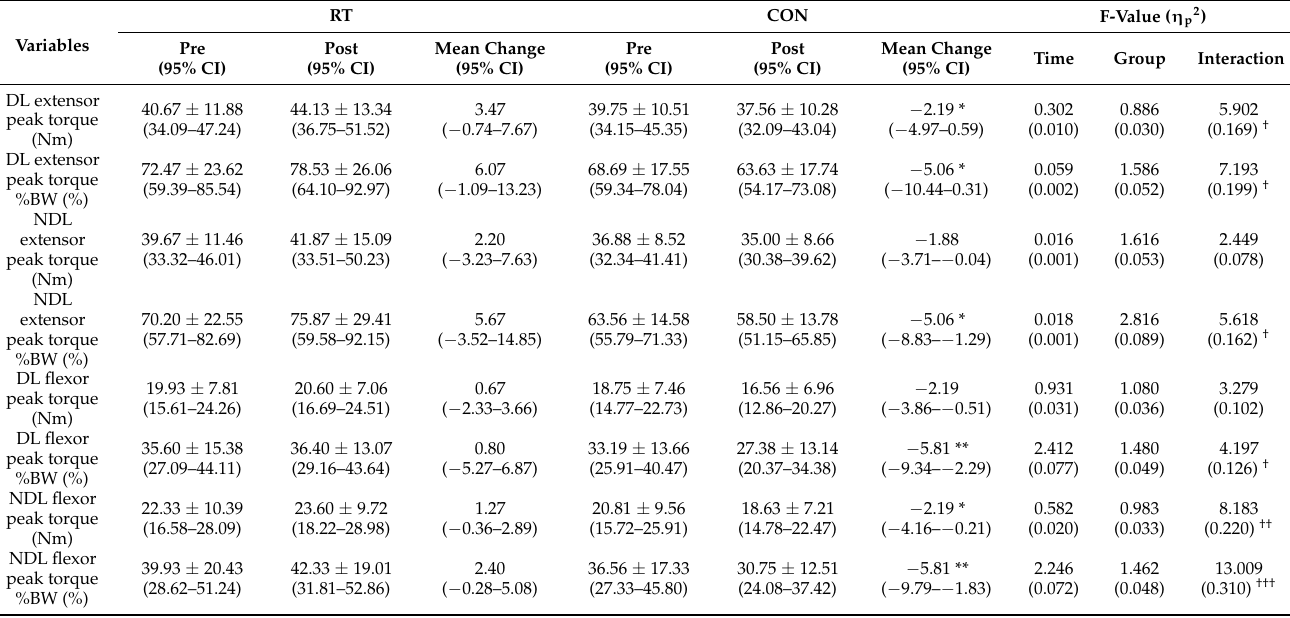
Table 6. Changes of isokinetic muscle strength at 180 ◦ /s between pre- and post-tests in obese older